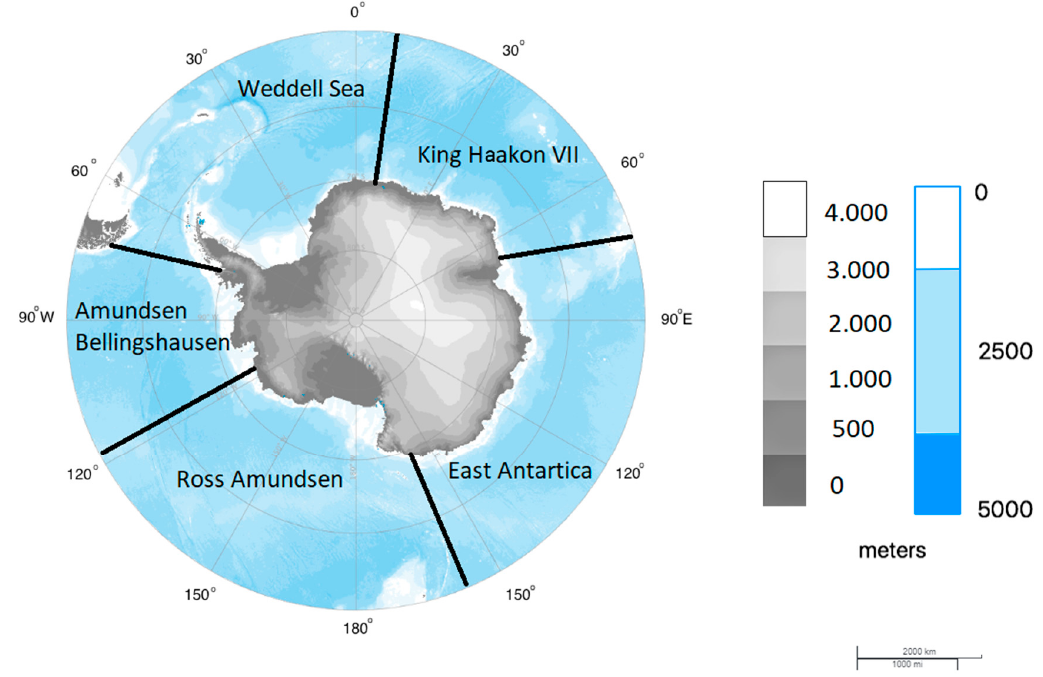
Figure 1. Topography (shaded in grayscale, m), ocean depth (shaded in blue scale, m), and boundaries of the austral seas around Antarctica following [18].